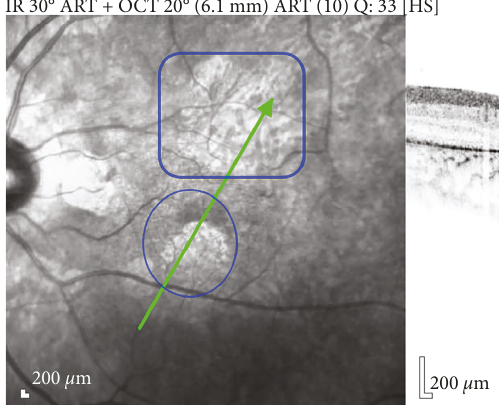
Figure 3: Optic coherence tomography scan showing a patch of atrophy in the outer retina inferotemporal to the fovea with photoreceptor layer